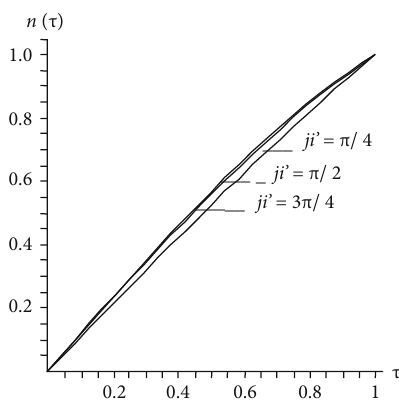
Figure 8: Fluid temperature for various values of j i / with q = 1 : 0 ,